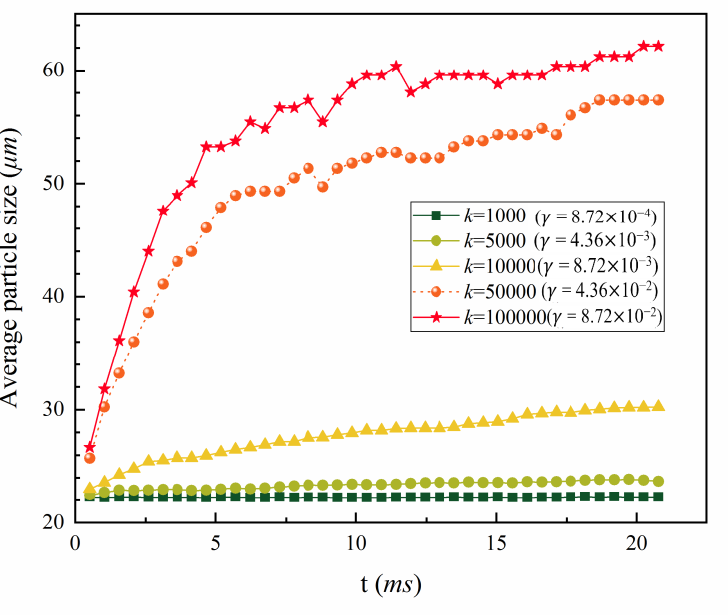
Figure 2. Variation of the average particle size with different surface energy values for the 20 μm particles.